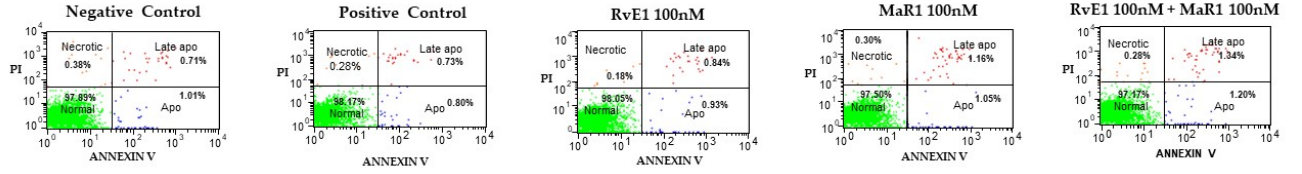
Figure 2. Rates of apoptosis in hBMMSCs in the control and experimental groups after RvE1 and MaR1 treatment alone or together in response to LPS-induced inflammation using Annexin V/propidium iodide double staining by flow cytometry. The experiments were repeated three times ( n = 3) and there were no significant differences in apoptosis between the five study groups ( p = 0.71). Representative graph shows the fractions of viable and dead cells across the different study groups.